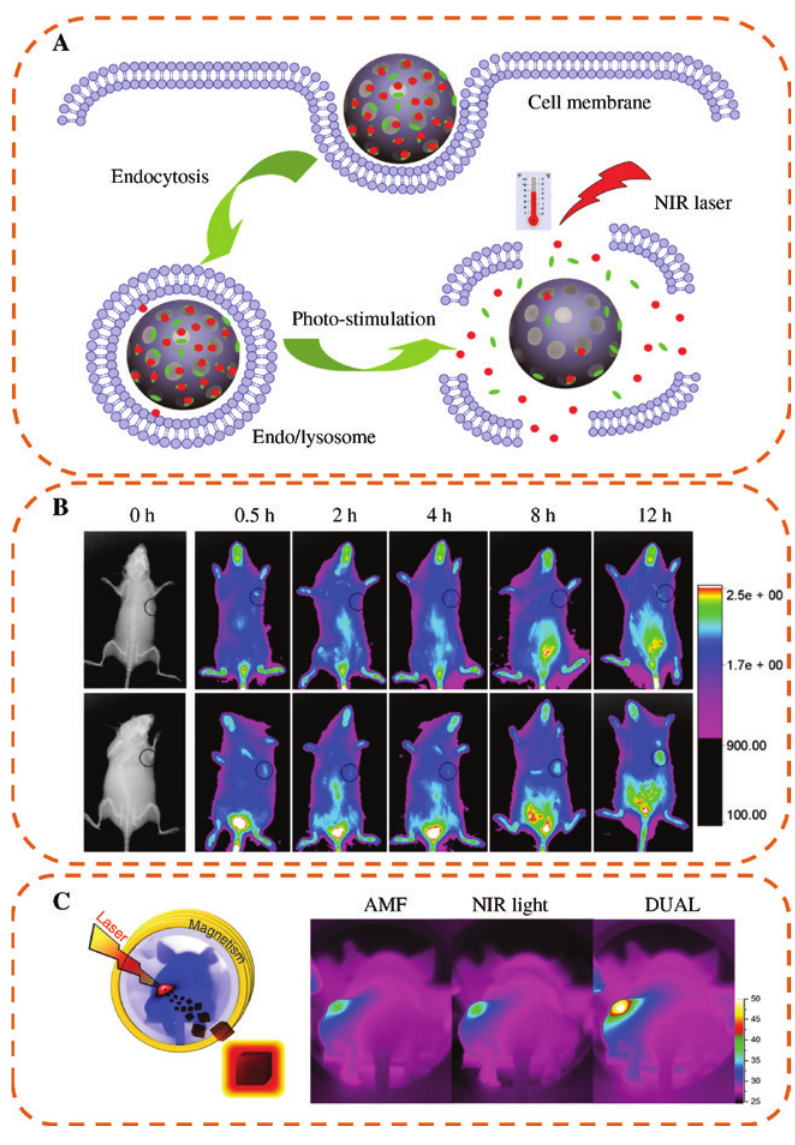
Figure 9: Example of light-treatment with inorganic NPs. (A) Schematic diagram of employment of silica NPs as light-sensitive drug carriers. (B) In vivo NIR imaging of tumour-bearing mice intravenous injected with free NIR-dye (IR783) solution (upper row) and IR783-loaded HA–TiO injection. (C) Thermal images obtained with the IR camera in mouse, after intratumoural injection IONPs, in the left-hand tumour, and after 10-min application of AMF, NIR-laser irradiation, or DUAL (both effects). Reprinted with permission from [125, 147, 148]. Copyright 2015